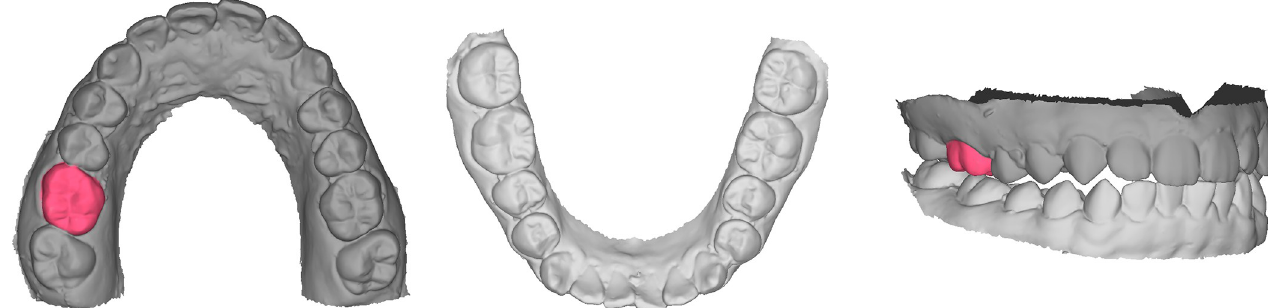
Fig 6. A & B: Example of a maxillary teeth model (left) and a mandibular teeth model (right). C: Demonstration of maxillary teeth model and its antagonist mandibular teeth model at maximal intercuspal position.